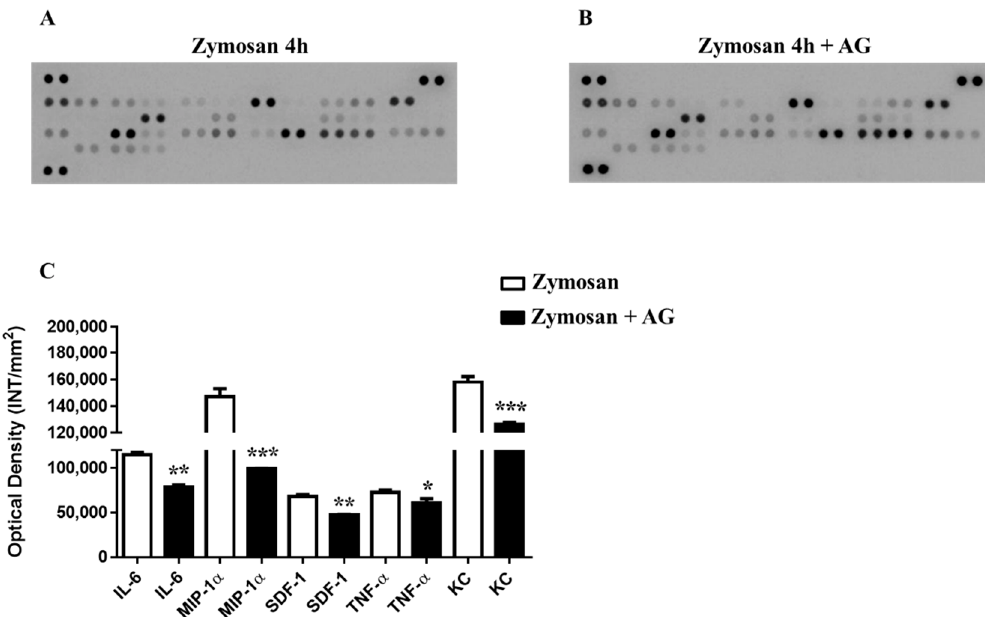
Figure 6. ( A ) Inflammatory fluids in zymosan and zymosan + AG-injected mice at 4 h. Inflammatory fluids obtained from peritoneal cavities were assayed using a proteome profiler cytokine array. Mean changes (± S.E.M) between zymosan (500 mg/kg) and ( B ) zymosan + AG-injected mice (150 mg/kg) of three separate experiments with n = 7 mice, ( C ) are expressed as increase in the optical density (INT/mm 2 ) between the two groups. * p < 0.05, ** p < 0.01 and *** p < 0.001 vs. zymosan-treated mice.